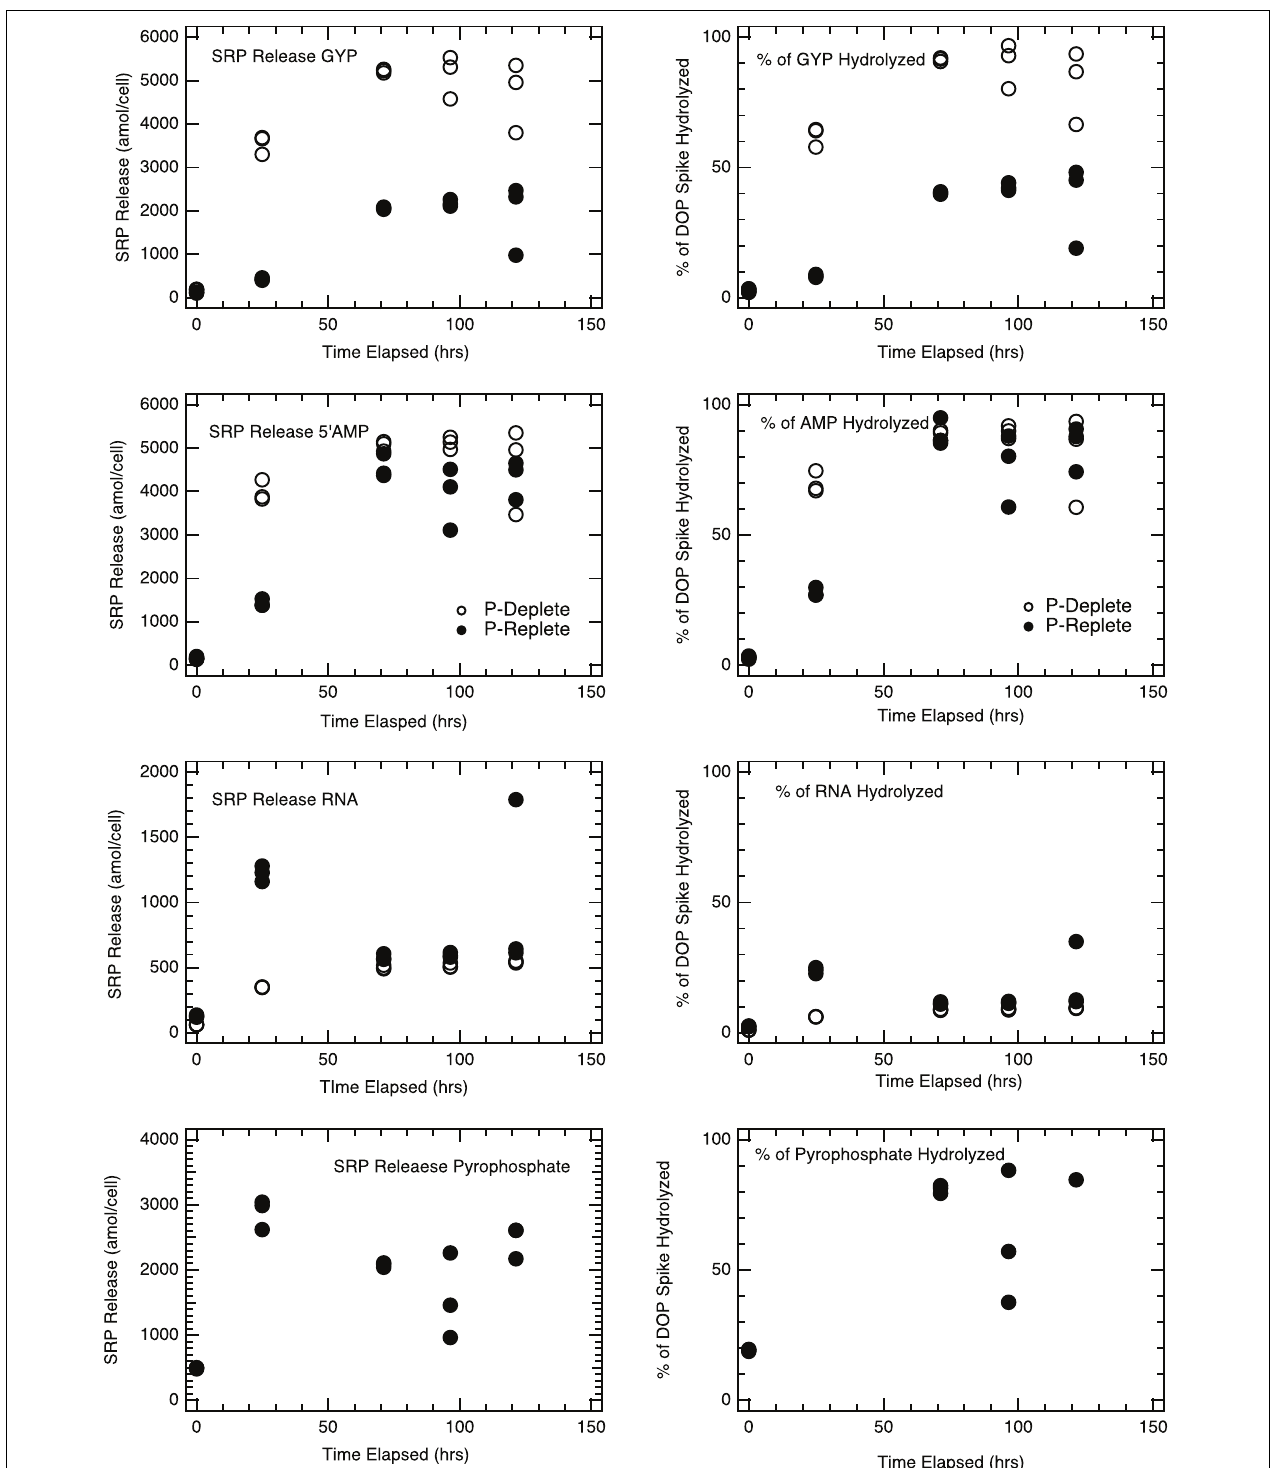
FIGURE 4 | Hydrolysis of model DOP compounds in E. coli lysates: E. coli MG1655 P-Deplete and P-Replete lysates incubated with a range of DOP compounds (1 mM DOP concentration in lysate solution at beginning of incubation) were monitored for [SRP] over time. Model DOP compounds used include glycerophosphate (GYP), 5’adenosine monophosphate (5’AMP), ribonucleic acid (RNA), and pyrophosphate (Pyro-P). For each time point, triplicate lysate incubations were measured, and the analytical error bars for each measurement are within the size of the symbols. SRP release in GYP incubations is the only treatment above where p-conditions represent statistical differences in SRP regenerated; p <